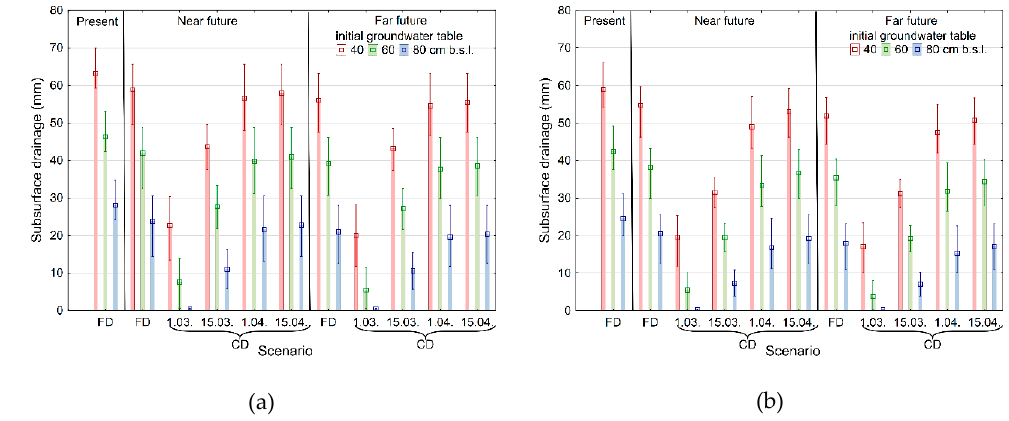
Figure 7. Subsurface outflows from free drainage network and with the use of various CD scenarios for the present and for the near and far future for drainage networks with spacings of 7 m ( a ) and 14 m ( b ). Bar charts with error bars show the average values, as well as the minimum and maximum values for the years 2014, 2017, and 2018.